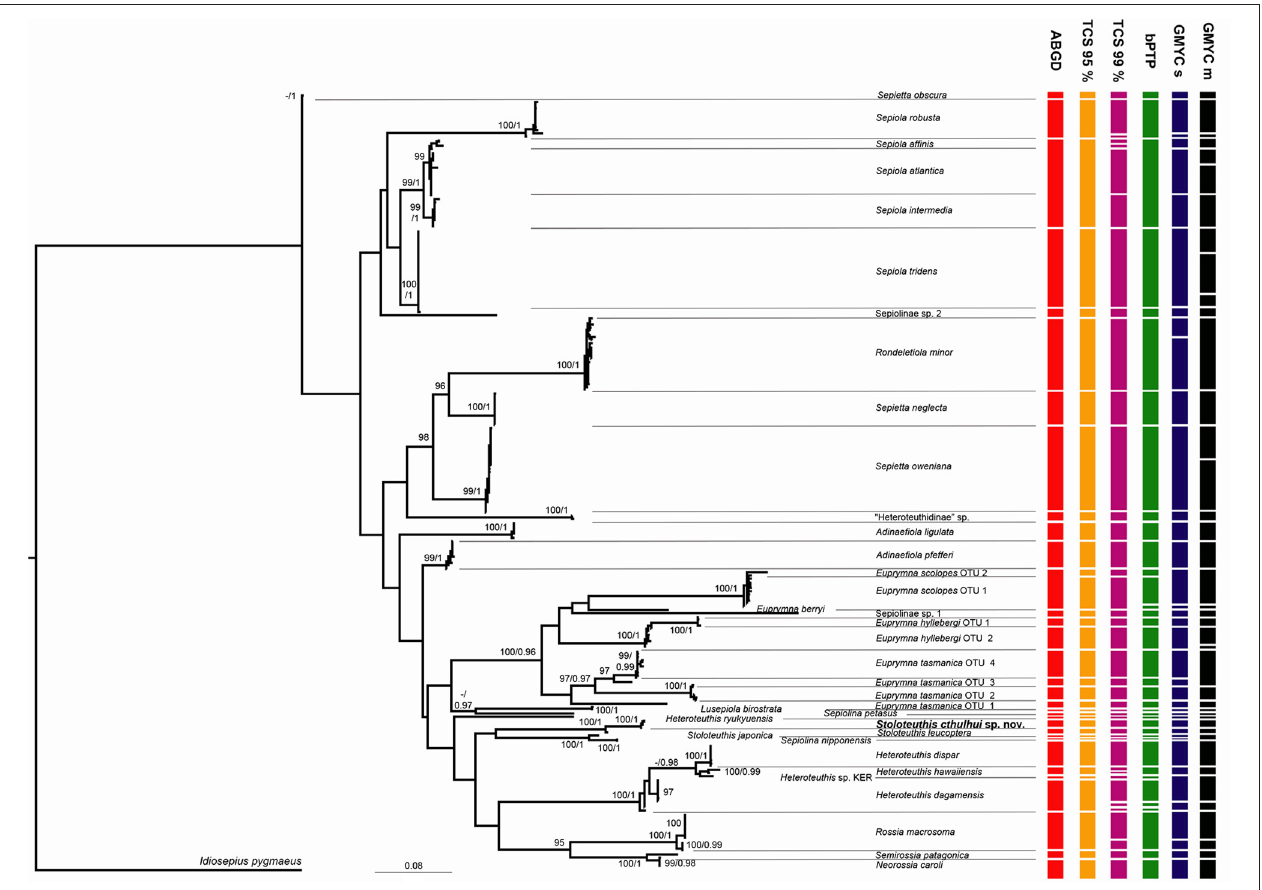
FIGURE 2 | Maximum Likelihood tree obtained with the software IQTree. Numbers on the nodes signal bootstrap percentages after 2,000 ultrafast bootstrap generations and posterior probabilities from the Beast analysis. Only support values above 95% and 0.95 are indicated. Results of molecular species delimitation methods (ABGD, TCS 95%, TCS 99%, bPTP, GMYC single threshold and GMYC multi-threshold, the last two abbreviated as GMYC s and GMYC m, respectively) are